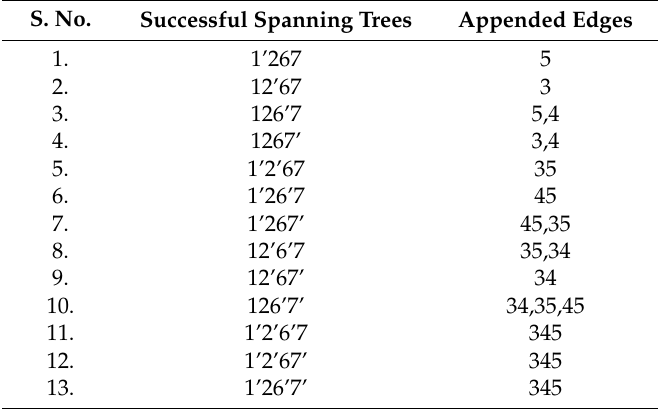
Table 1. Generation of successful spanning trees (STis).